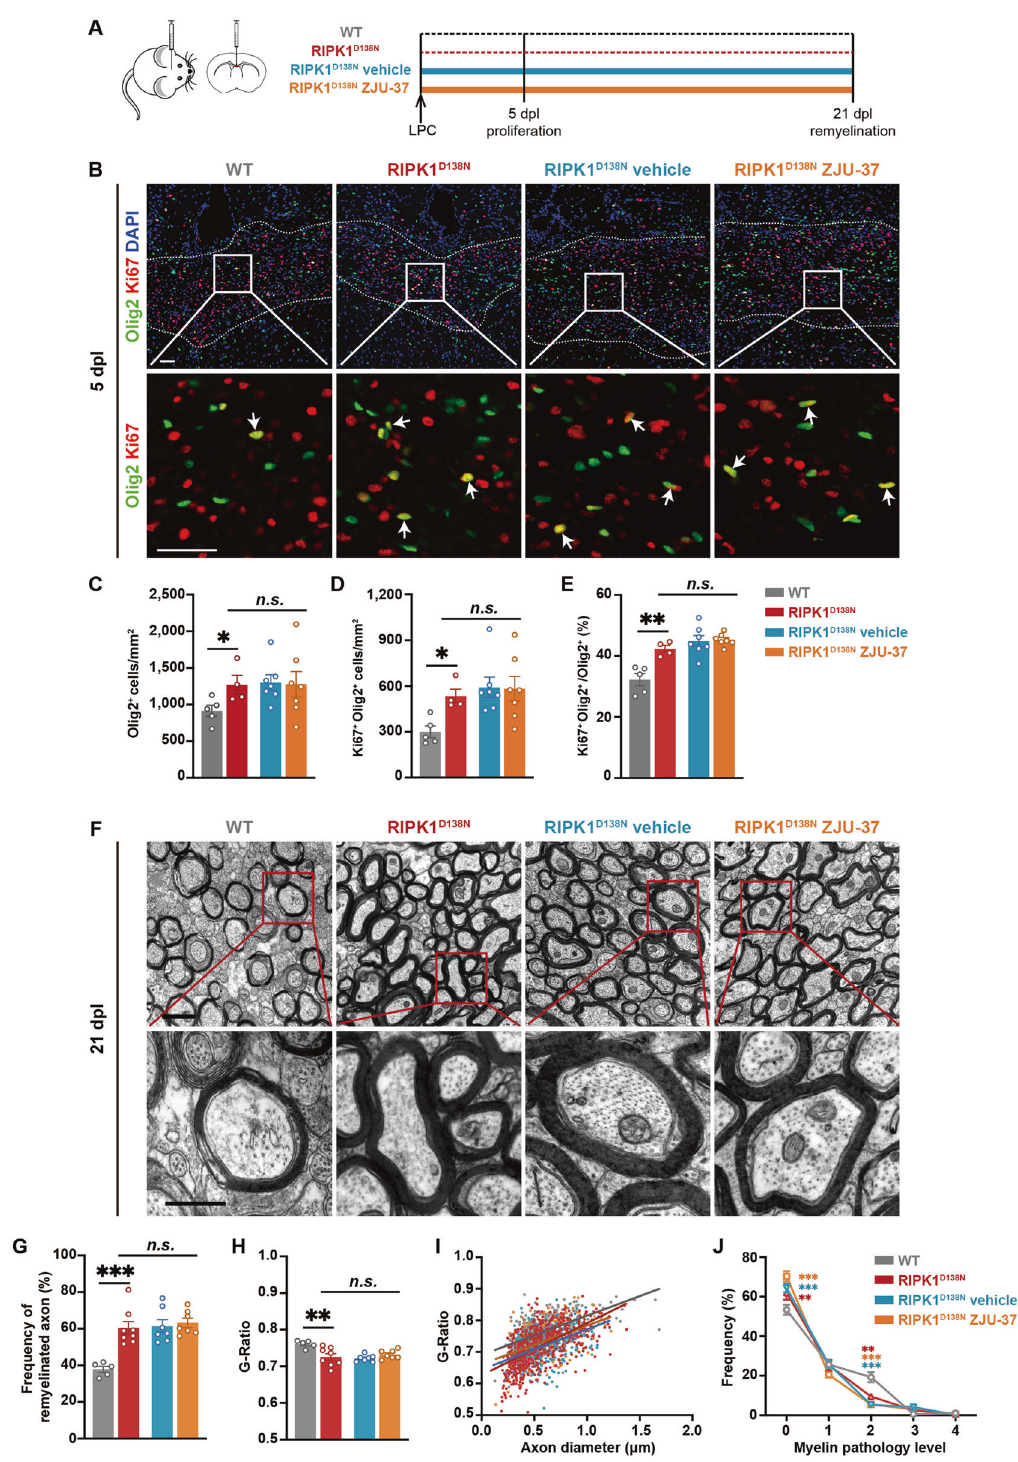
Fig. 6 ZJU-37 promotes OPC proliferation and enhances remyelination by inhibiting RIPK1 kinase activity. A Schematic diagram of the experimental design. B Representative fl uorescence images of the proliferating OPCs within the demyelination region at 5 dpl. Scale bars, 50 μ m. C – E Quanti fi cation of ( C ) the oligodendrocyte lineage cell numbers, ( D ) the proliferating OPCs numbers and ( E ) the proportion of proliferating OPCs in all oligodendrocyte lineage cells within the lesion region at 5 dpl (one-way ANOVA, Tukey ’ s post hoc test, n = 5 mice in the WT group, n = 4 mice in the RIPK1 D138N group, n = 7 mice in the RIPK1 D138N vehicle and RIPK1 D138N ZJU-37 group). F Representative transmission electron micrographs within the demyelination region at 21 dpl. Scale bars, 1 μ m (upper row), 500 nm (lower row). G – J Quanti fi cation of ( G ) the remyelinated axons (one-way ANOVA, Tukey ’ s post hoc test), ( H ) G-Ratio (one-way ANOVA, Tukey ’ s post hoc test), ( I ) individual G-Ratio distribution (linear regression) and ( J ) the myelin pathology level (two-way repeated ANOVA, Sidak ’ s post hoc test) within the demyelination region at 21 dpl ( n = 5 mice per group). All data are presented as mean ± SEM. * P < 0.05, ** P < 0.01, *** P < 0.001, n.s. no signi fi cance.